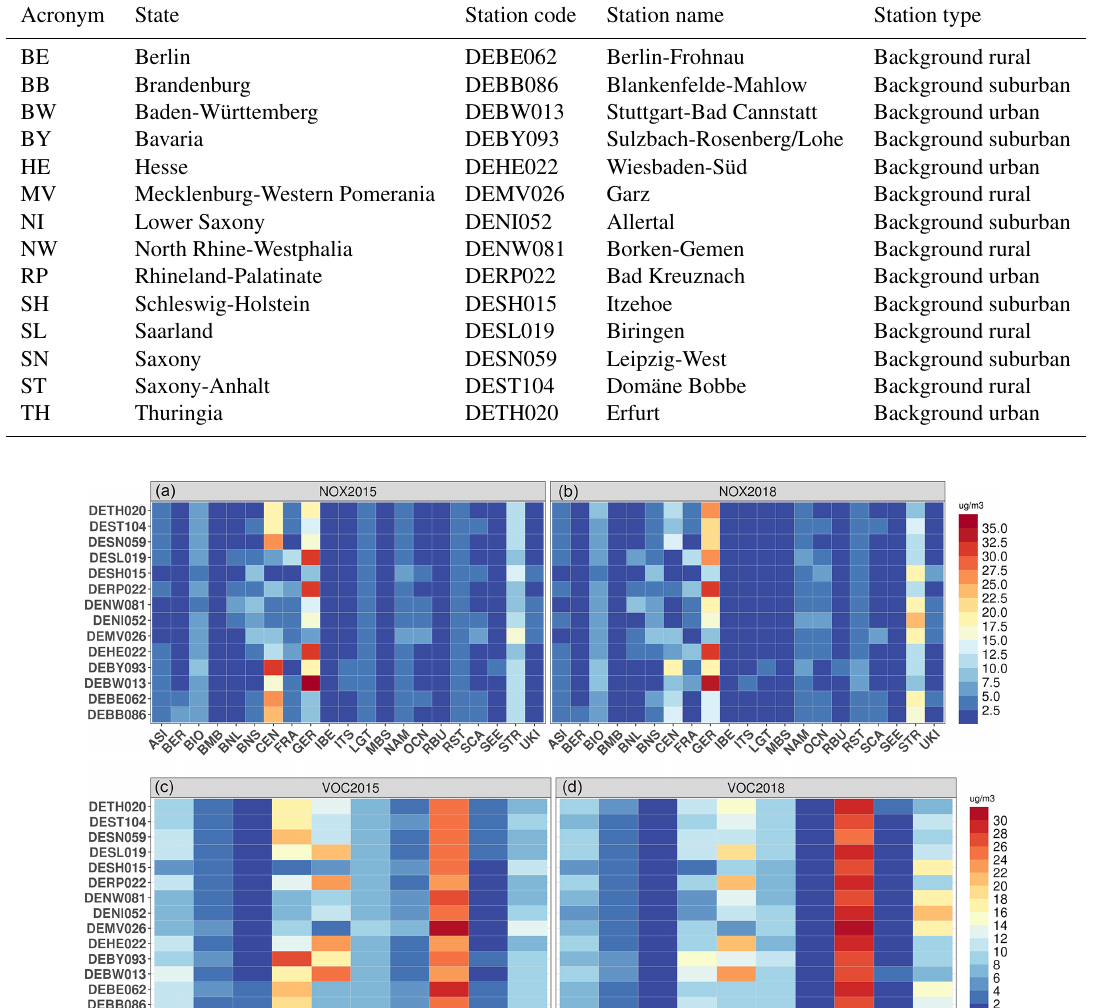
Table 7. List of selected stations.